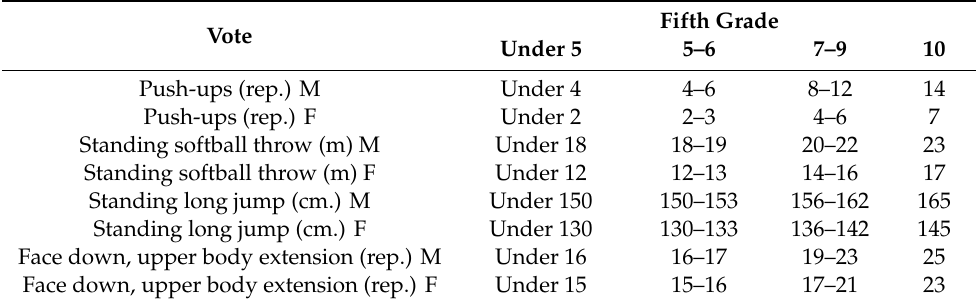
Table 1. National grade standard in the fifth